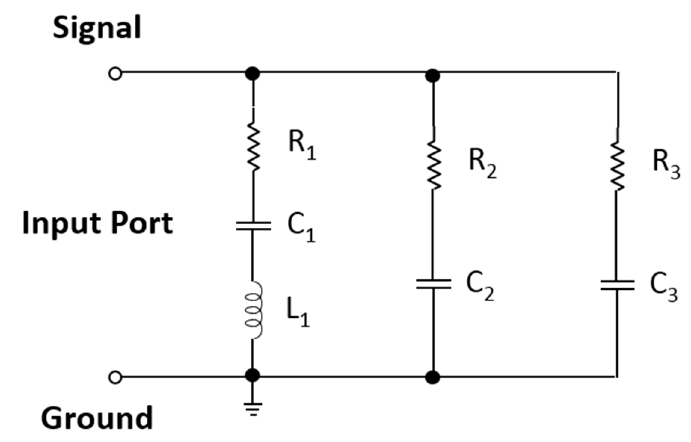
Figure 10. A modified version of the equivalent circuit for the studied microfluidic IDC sensor.